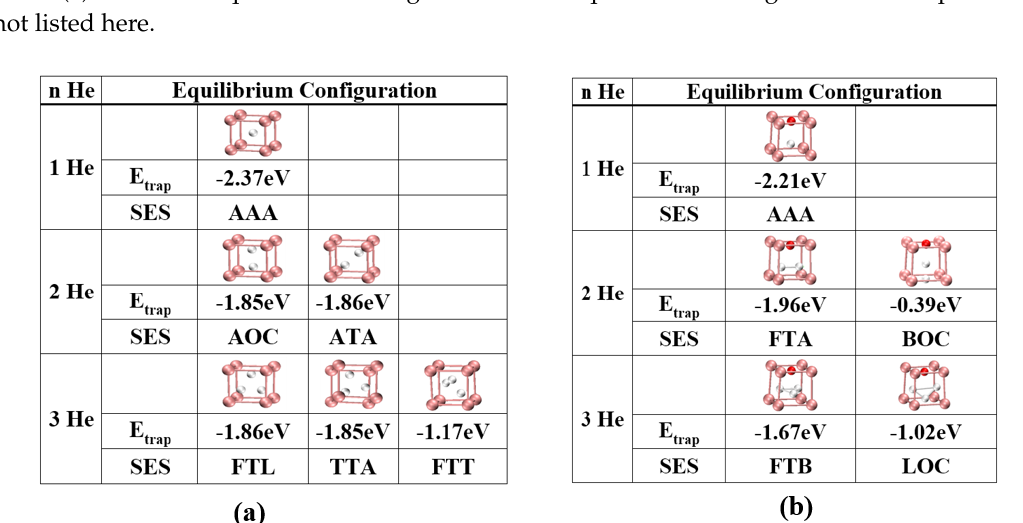
Figure 3. The equilibrium configurations and corresponding He trapping energy of the He cluster with a reference unit of: ( a ) Fe + Vac; and ( b ) Fe + O:Vac, respectively. The Fe atom and the He atom are presented as pink and white,